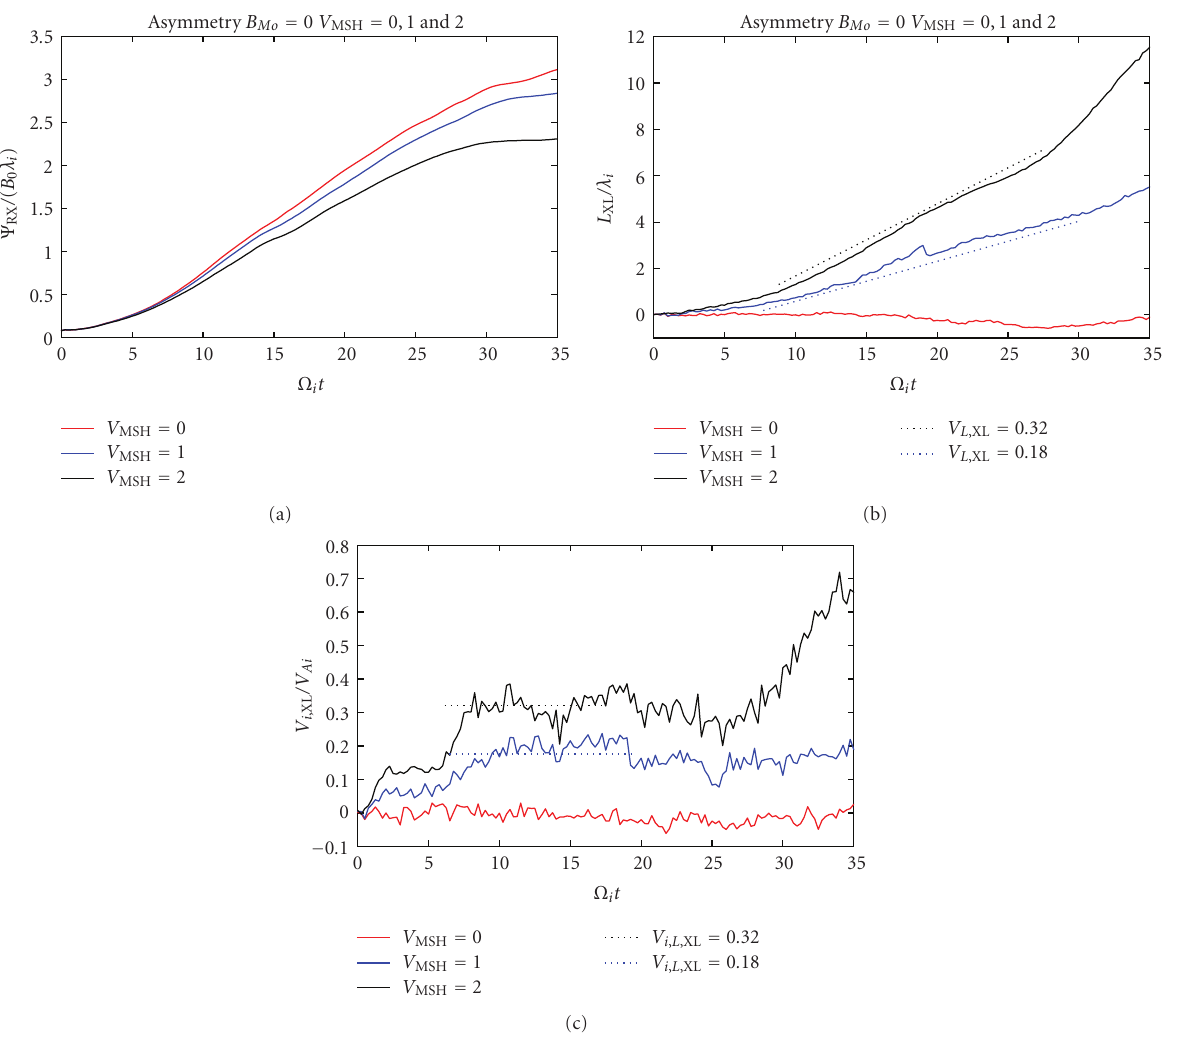
Figure 6: The results of nonzero V MSH cases without guide field. (a) Growth curves of reconnected flux. (b) The L -coordinates of the X-lines versus time. (c) The X-line speeds compared with the ion and electron flow at the X-line.